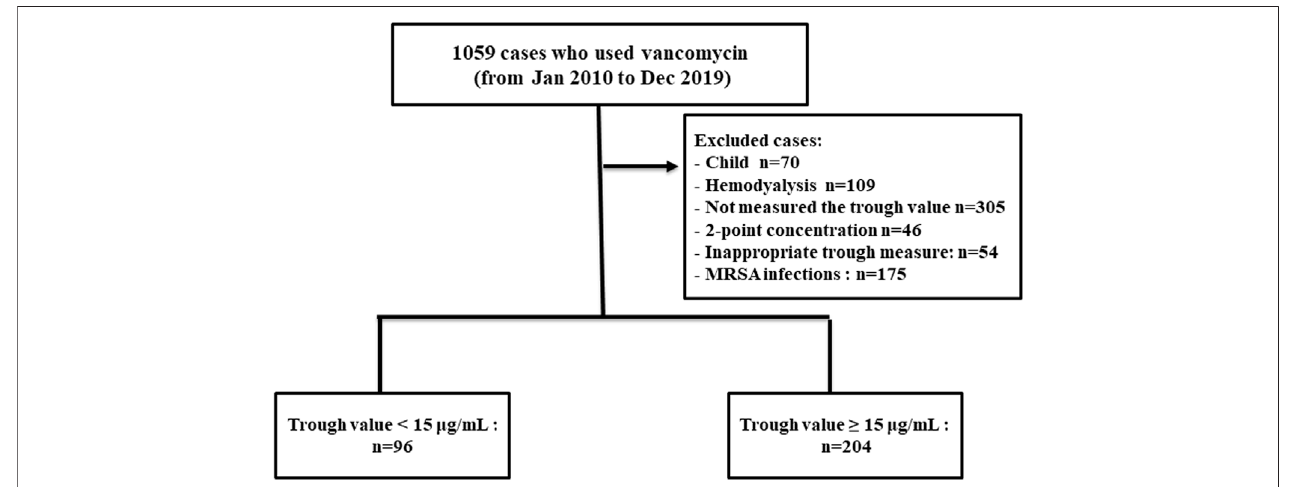
FIGURE 1 | Flowchart of the study